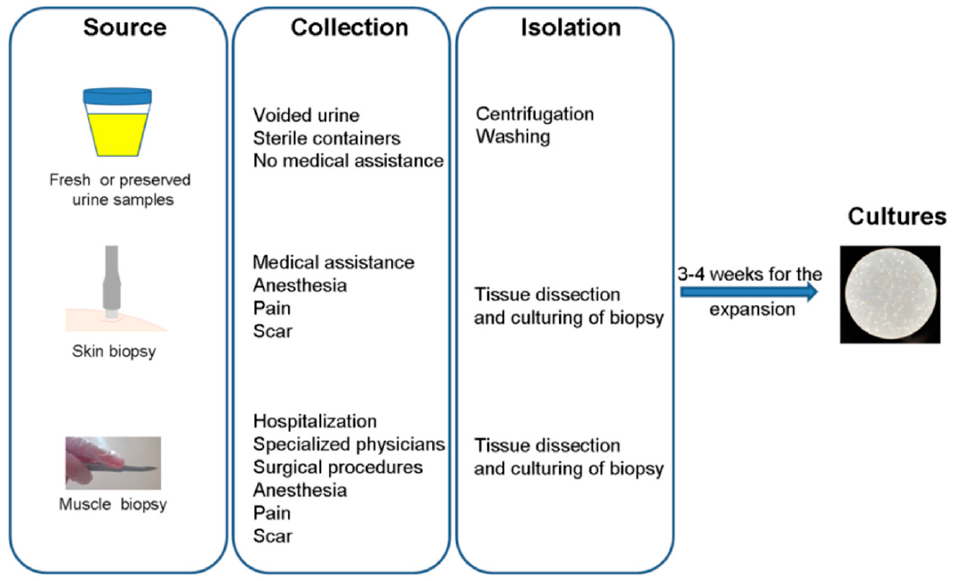
Figure 2. Schematic overview of three methodological procedures for cell isolation from different sources.